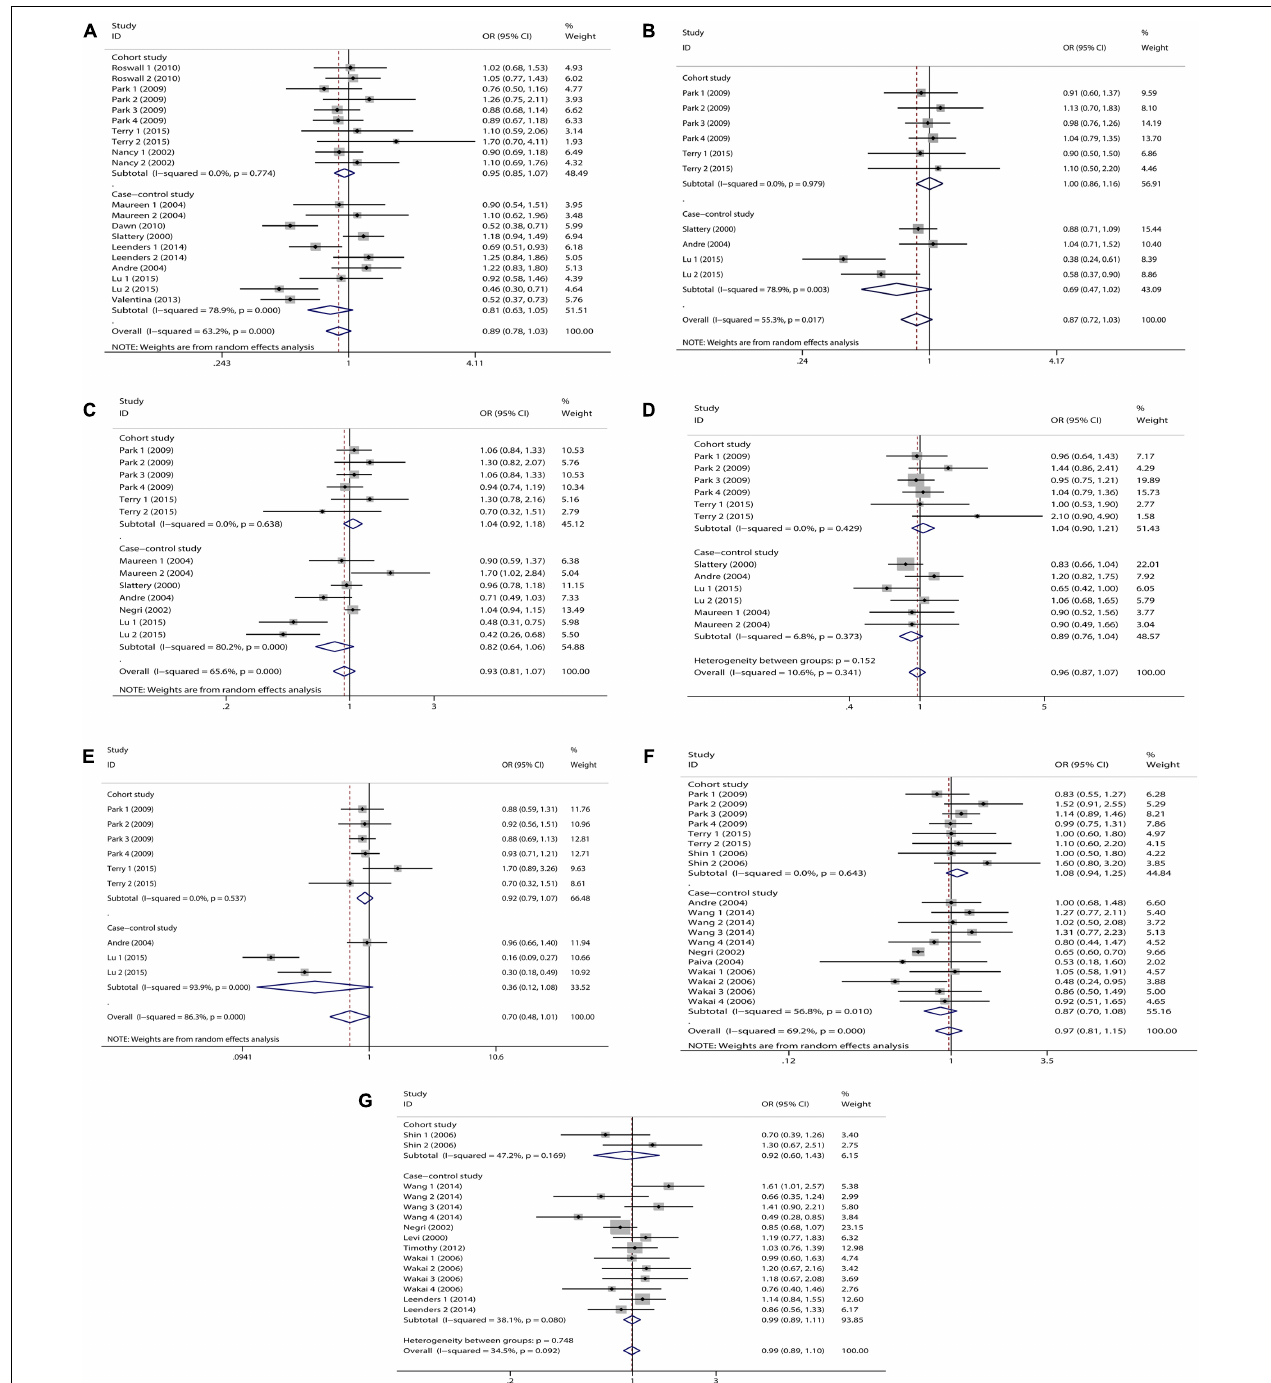
FIGURE 4 | Study type subgroup analysis of dietary carotenoid and retinol intake and colorectal cancer risk. (A) β -carotene; (B) α -carotene; (C) lycopene; (D) lutein/zeaxanthin; (E) β -Cryptoxanthin; (F) carotenoids; (G) retinol.